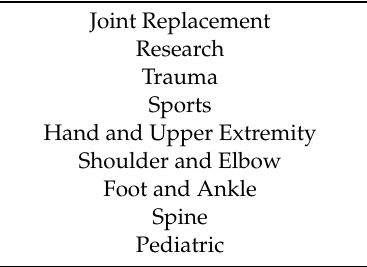
Table 1. Targeted Orthopedic Subspecialties Used in Secondary Search.